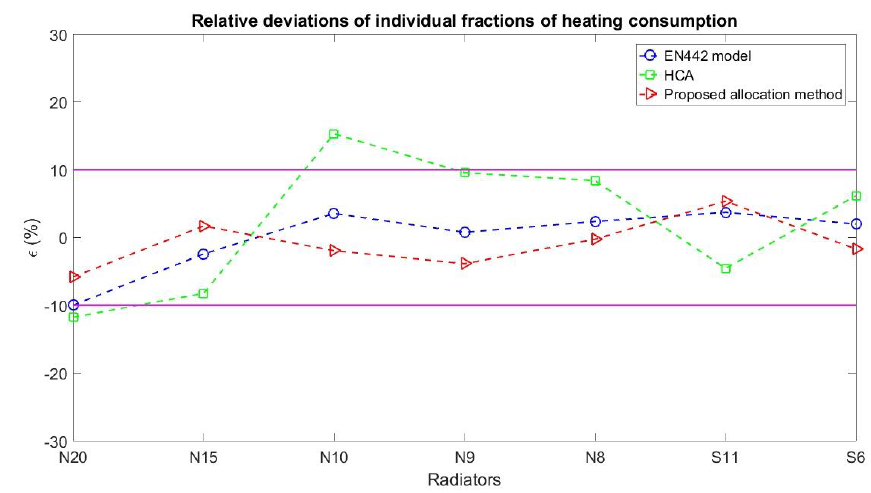
Figure 11. Relative deviations from reference measurements of individual fractions of heating consumption, only for the aluminum radiators (cast iron and steel radiators have been excluded for the assessment of heat cost